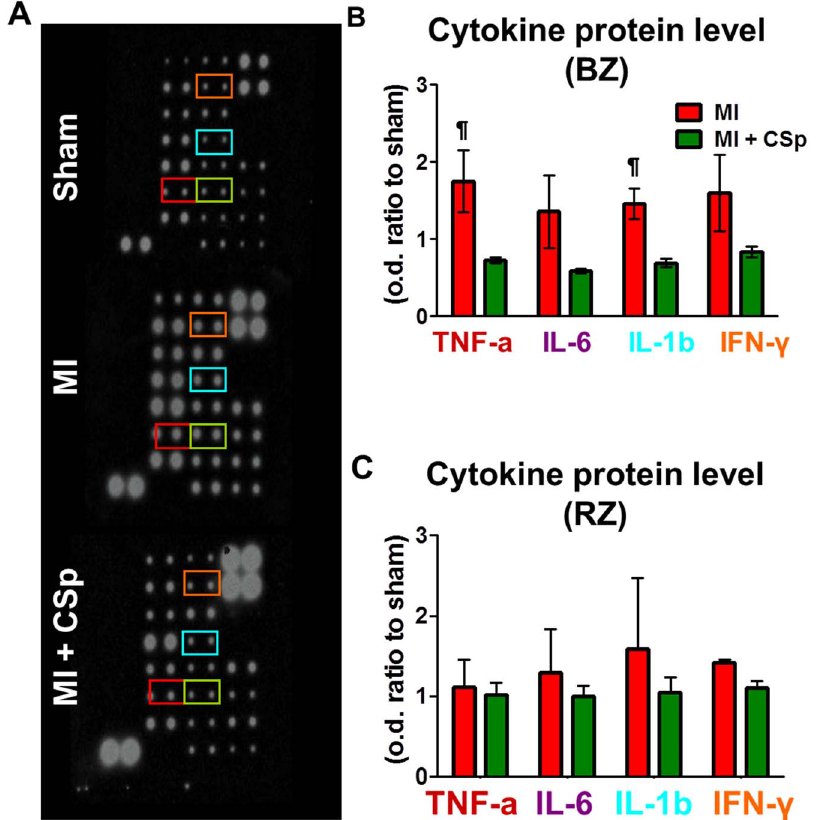
Figure 5. Proinflammatory cytokine expression. (A) Representative densitogram of cytokine expression in the peri infarct region 21 days post MI and CSp transplantation. (B, C). CSp treatment attenuated the inflammatory tissue cytokines’ expression. IL-1b and TNF- a were significantly decreased in the peri-infarct region of the CSp transplanted myocardium while a trend was detected in the remote. Three different samples per group were analysed. Data are mean 6 SD. " p , 0.05 control vs. MI + CSp.